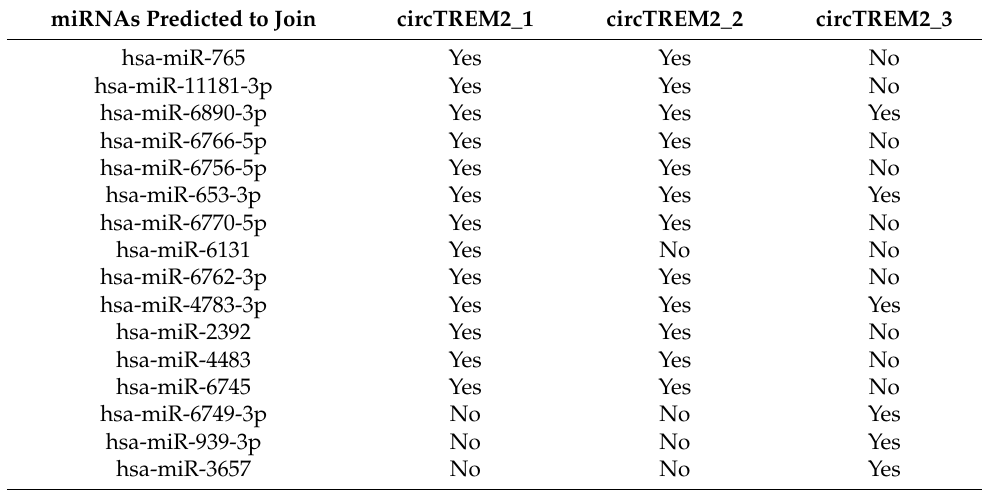
Table 1. miRNAs predicted with miRBD software to bind